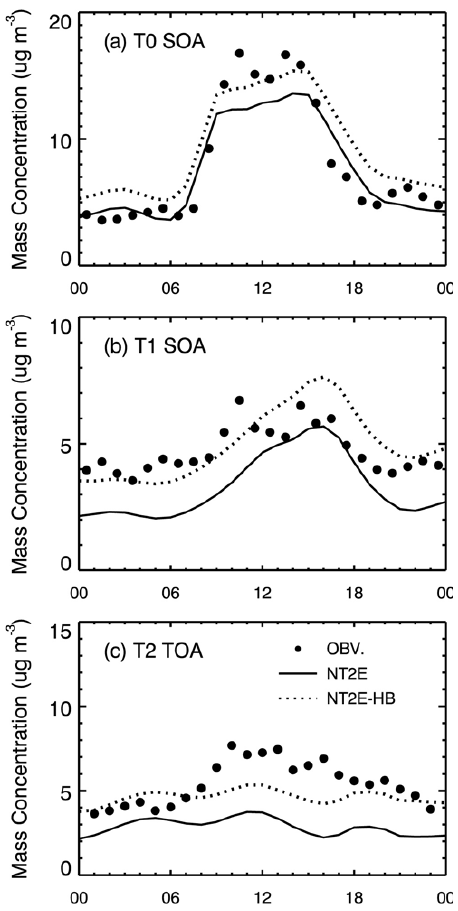
Fig. 15. Diurnal cycles of SOA (a) T0 and (b) at T1, and OA at T2 averaged during the period from 24 to 29 March 2006. Black dots: measurements; black solid line: the NT2E-SOA model; black dotted line: NT2E-SOA model with high background